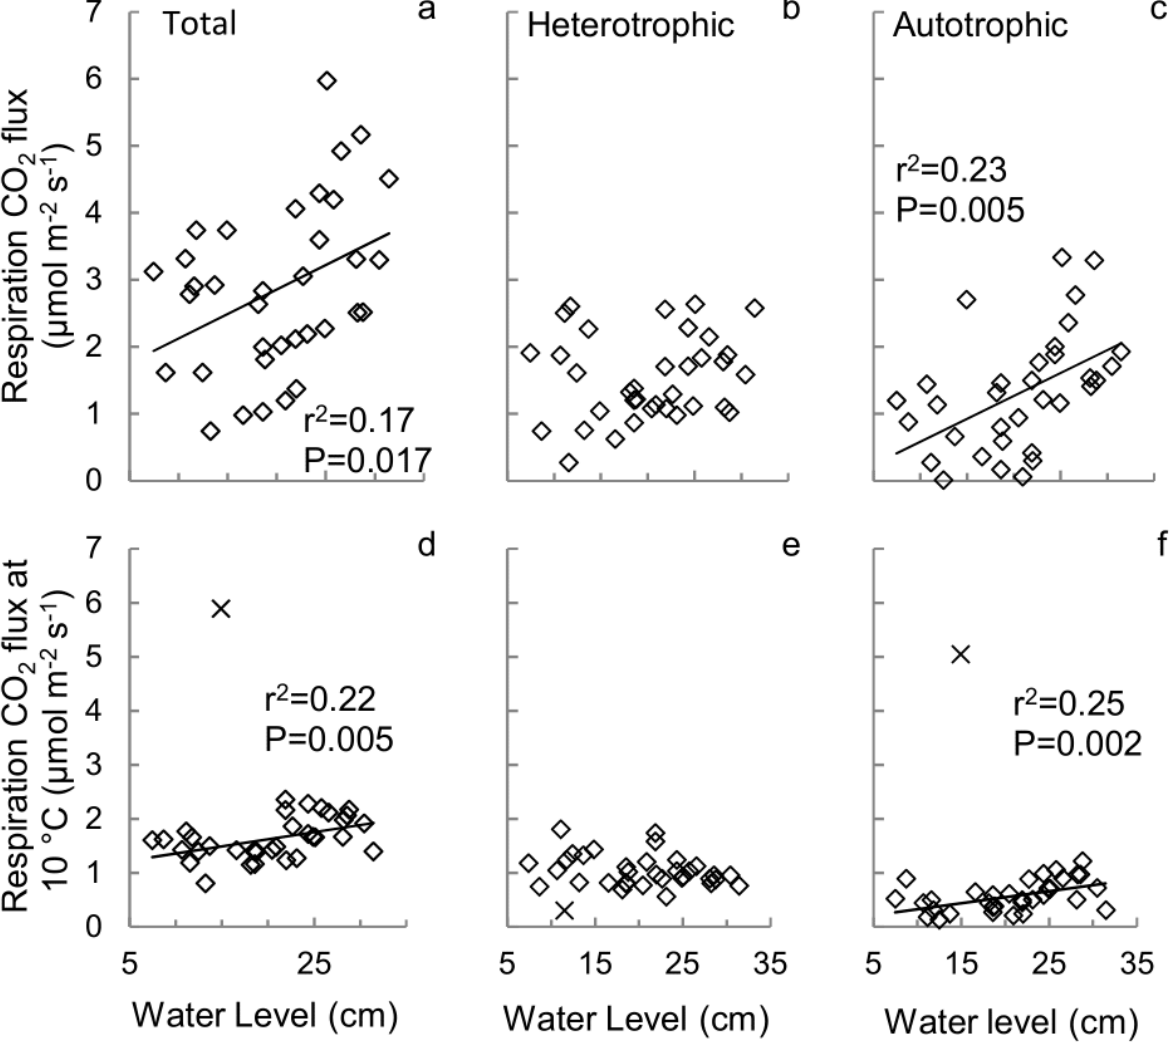
flux (μmol m -2 s -1 ) as measured (a, b, c) and 2